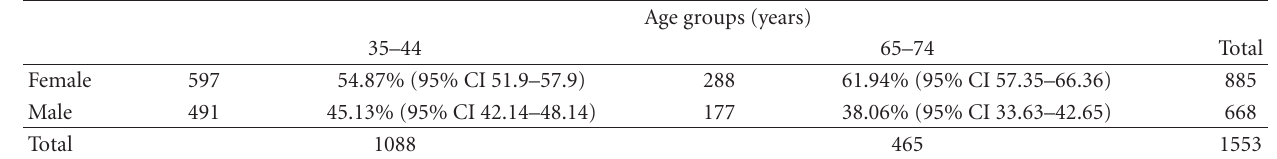
Table 1: Characteristics of the sample.